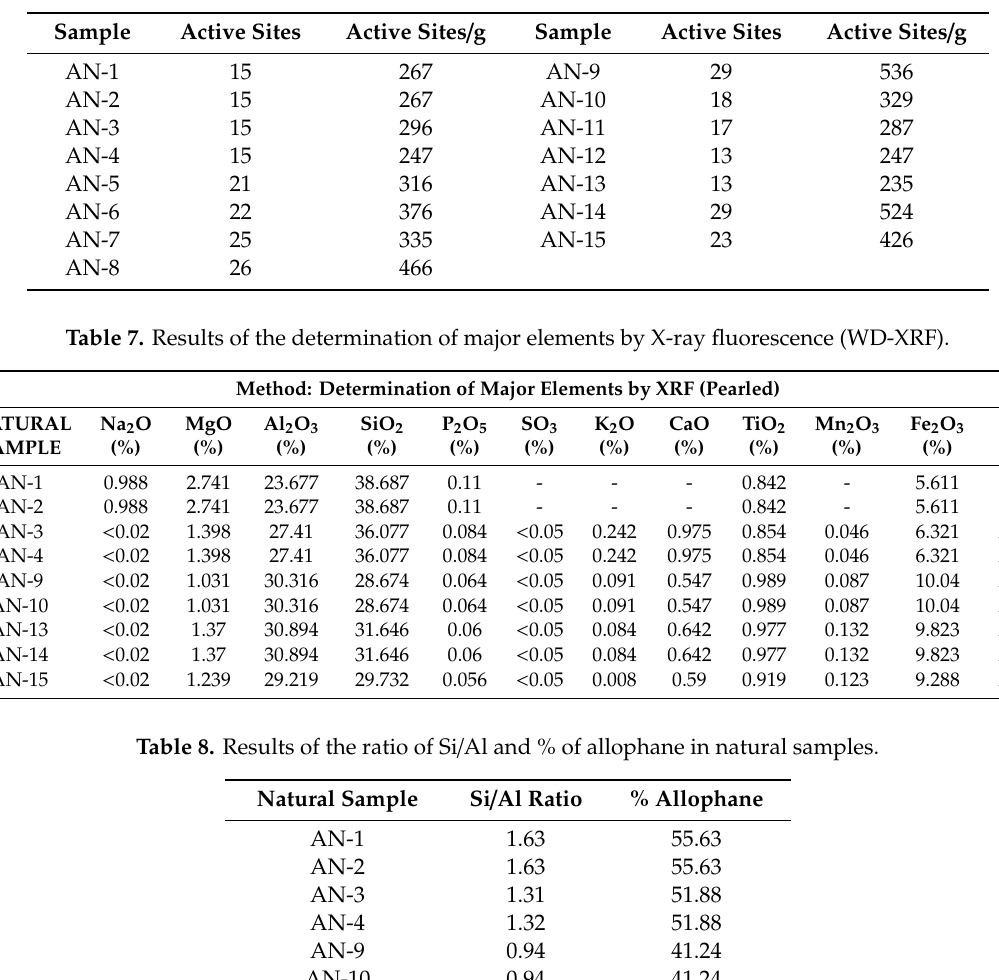
Table 6. Results of active sites of pure allophane.